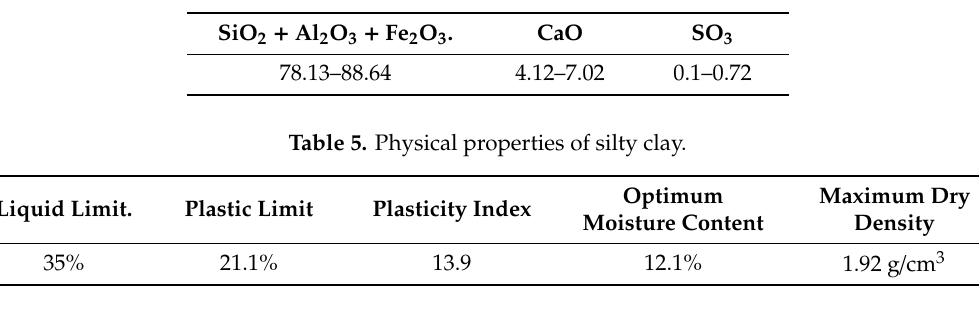
Table 4. Chemical composition of fly ash (%).